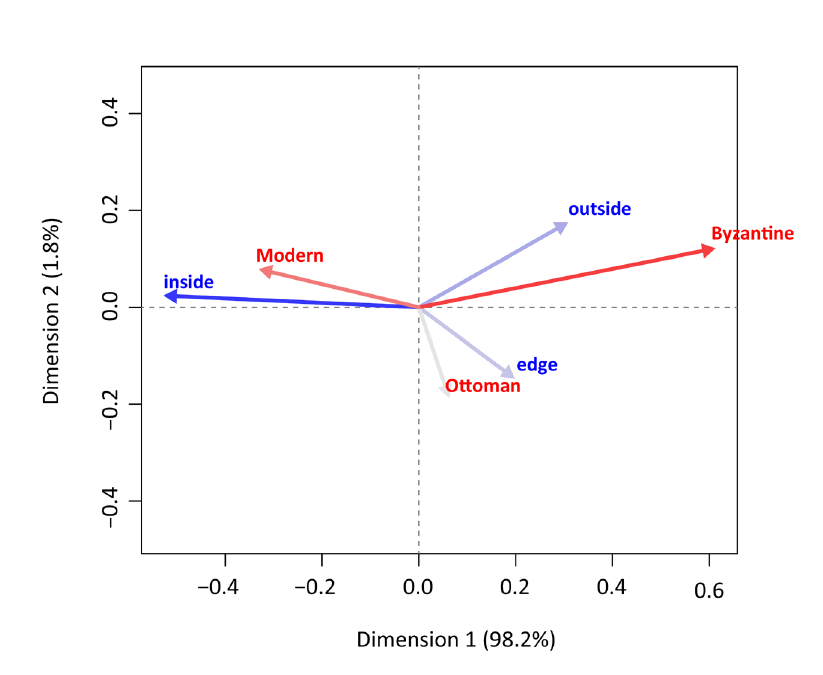
Figure 7. Correspondence Analysis of churches’ period of use and location in relation to